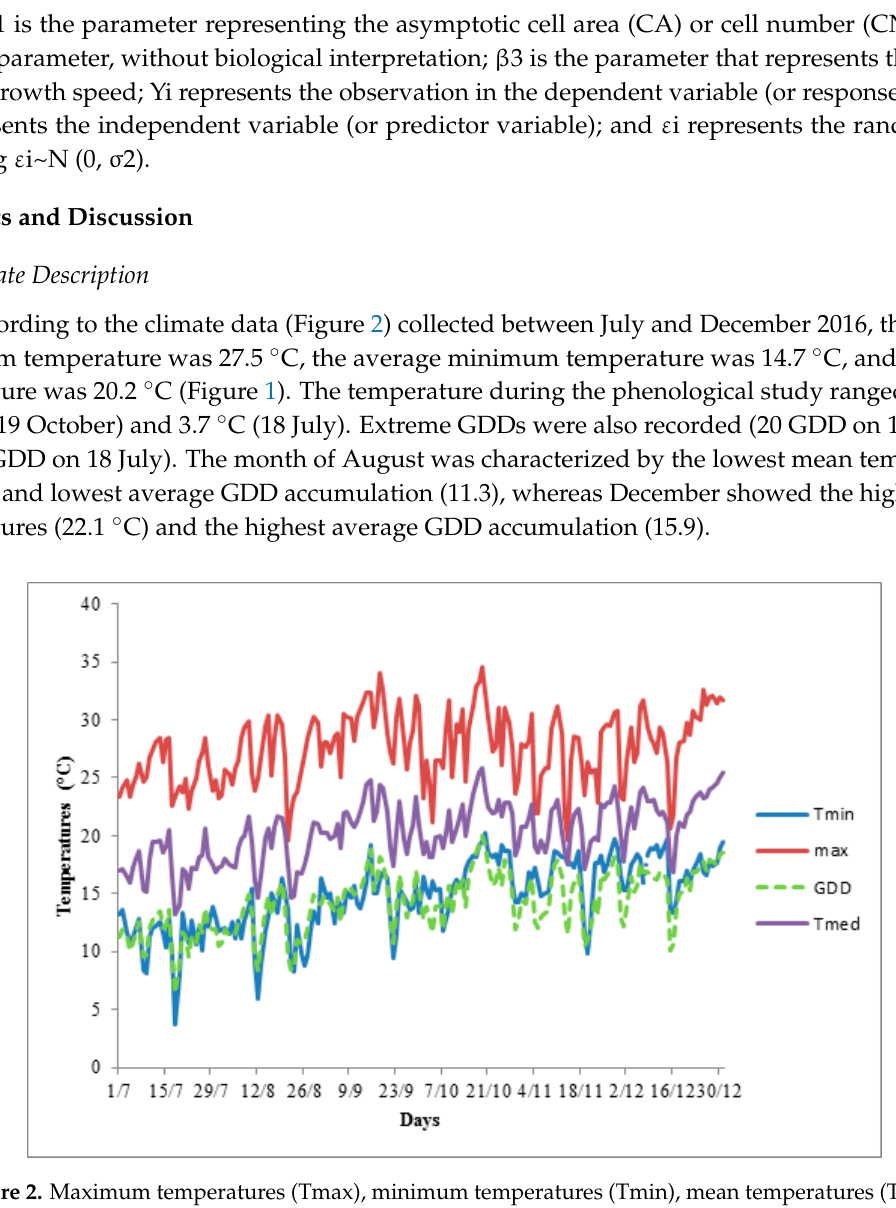
Figure 2. Maximum temperatures (Tmax), minimum temperatures (Tmin), mean temperatures (Tmed), and growing degree-days (GDD) from July to December 2016, in Lavras, MG, Brazil. Source: Main Weather Station of Lavras—UFLA/INMET.